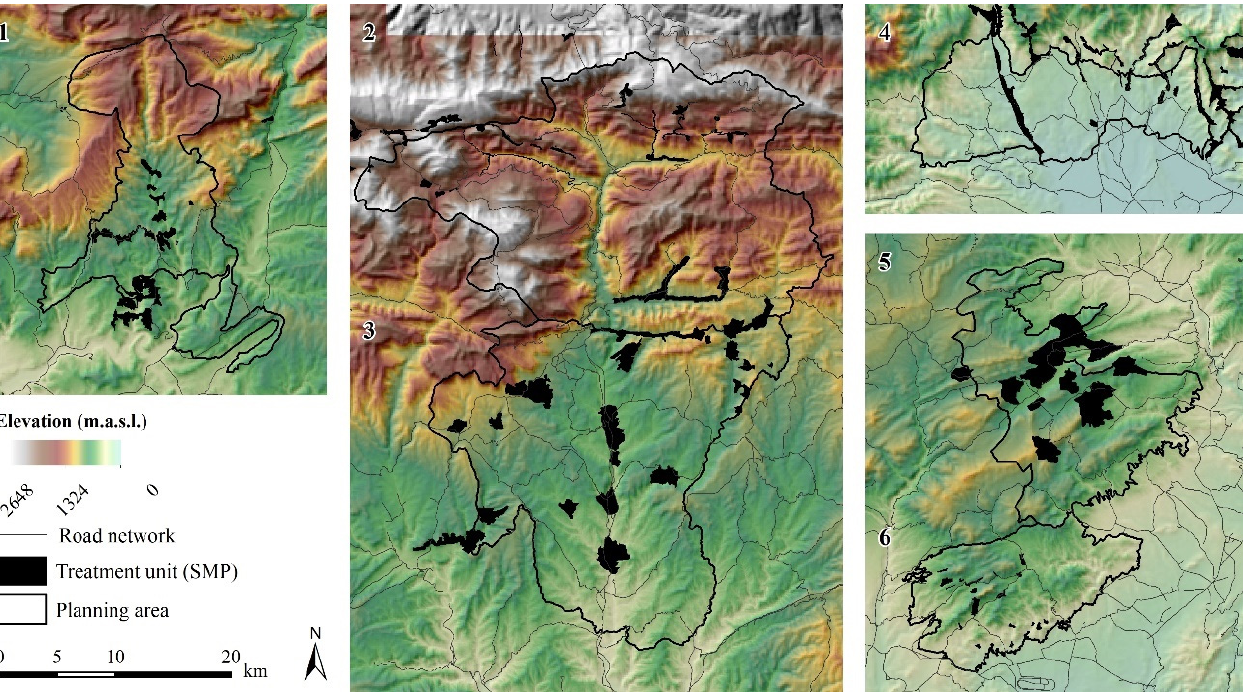
Figure 2. Location of the treatment units or strategic management points (SMPs) in the different planning areas. The numbers refer to the planning area codes (Appendix A; Figure 1). The design was based on expert criteria and provided by the Bombers GRAF team of the Firefighters of the Catalan Government. Table 1. Summary table with treatment cost data for fuel reductions in SMPs. The overstory is first reduced to a 60% canopy cover implementing a thinning from below, followed by prescribed fire (in conifer forest) or mechanical mastication (in broadleaved forests). We assumed average cost conditions for ongoing fuel reduction plans.